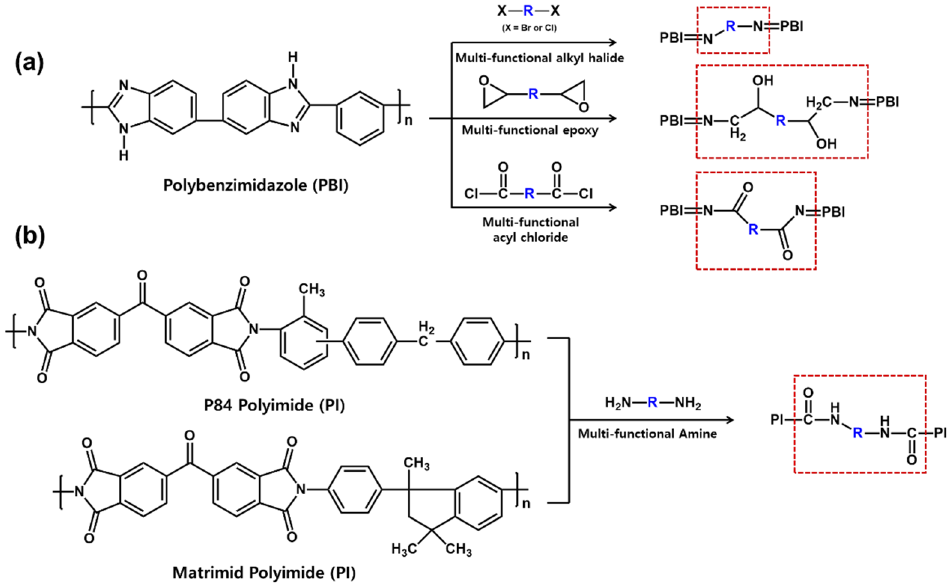
Figure 1. Cross-linking reaction scheme of ( a ) polybenzimidazole (PBI) and ( b ) polyimides (PI).